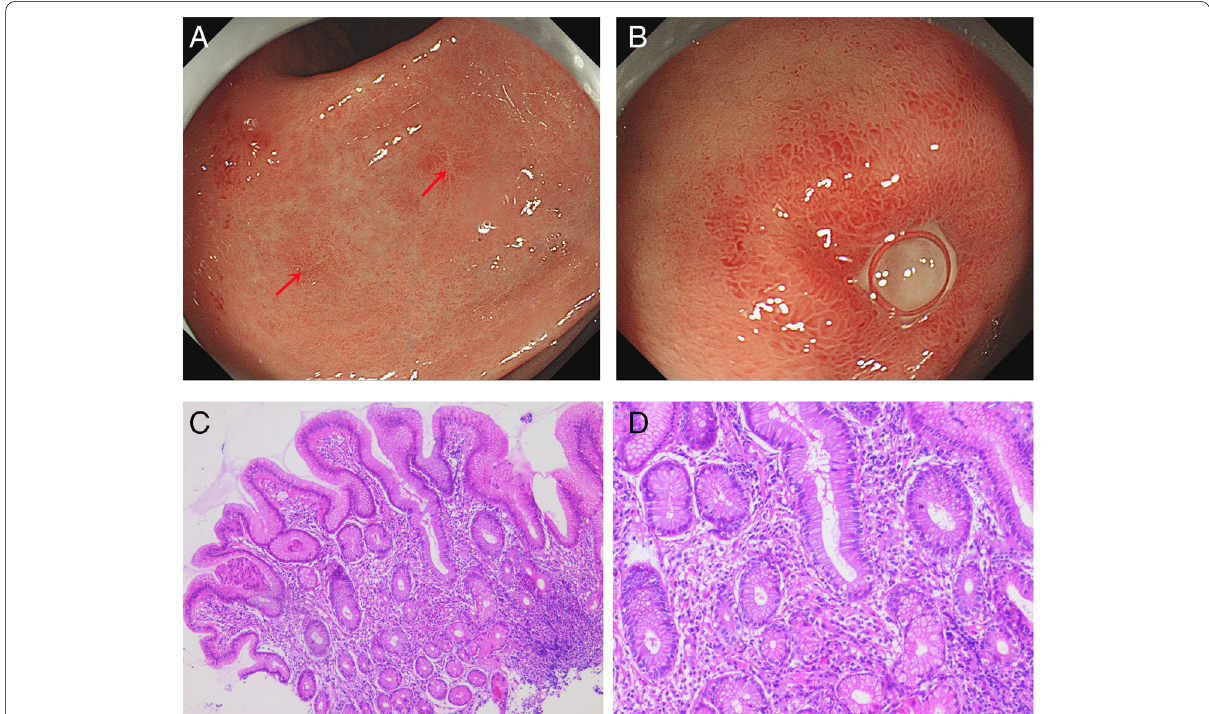
Fig. 4 A: Two scattered erosions seen on endoscopy after 1 week of anti-HP treatment,the red arrow is the biopsy forceps extraction point; B : a smaller bulbous ulcer on endoscopy. C (H&E